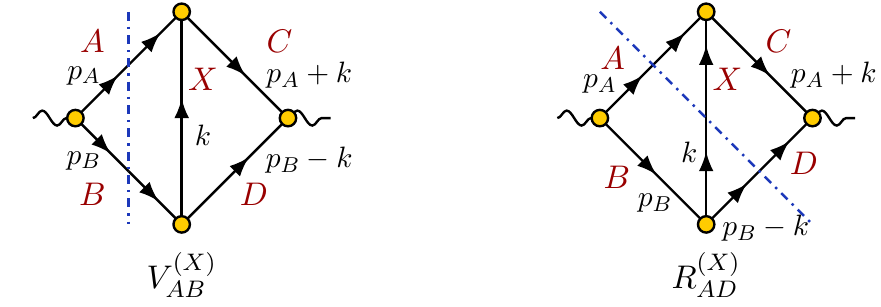
and A . 1 , 2 , 3 1 , 2